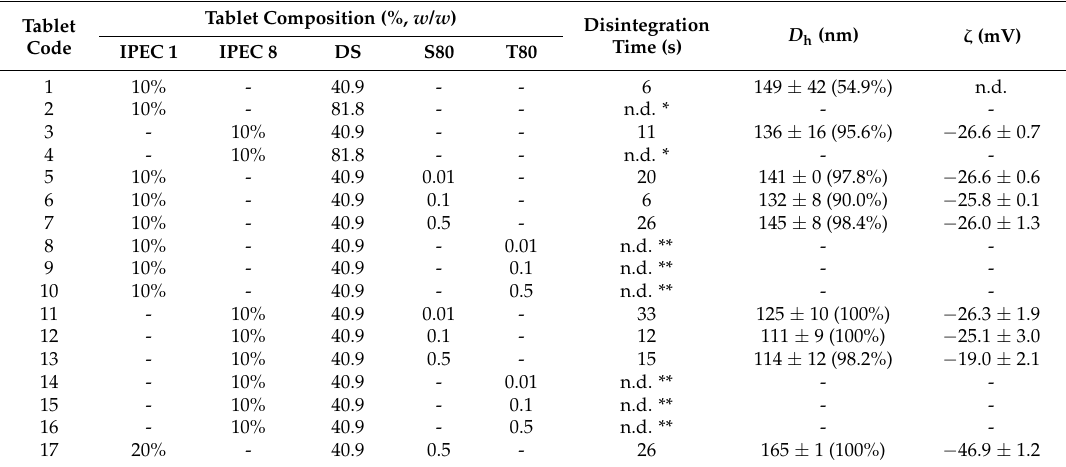
Table 2. Tablet composition and its influence on hydrodynamic diameter ( D h ) and zeta potential ( ζ ) of placebo IPECs after